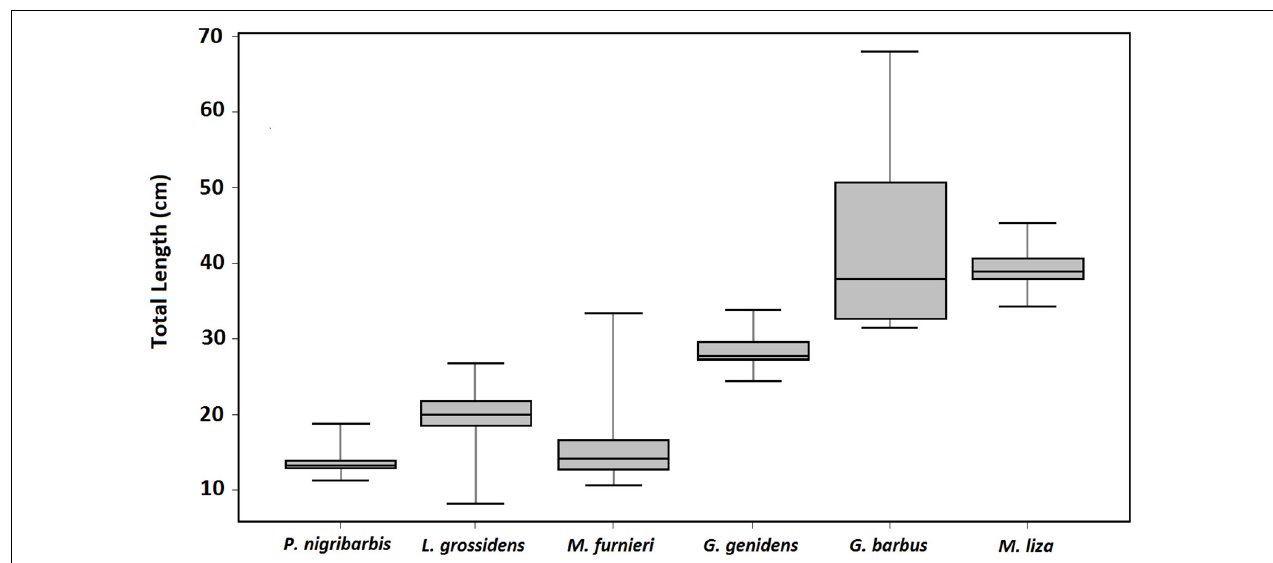
FIGURE 3 | Boxplot of the size profiles (total length, cm) of Parapimelodus nigribarbis, Lycengraulis grossidens, Micropogonias furnieri, Genidens genidens, Genidens barbus and Mugil liza sampled in Guaíba Lake, southern Brazil.